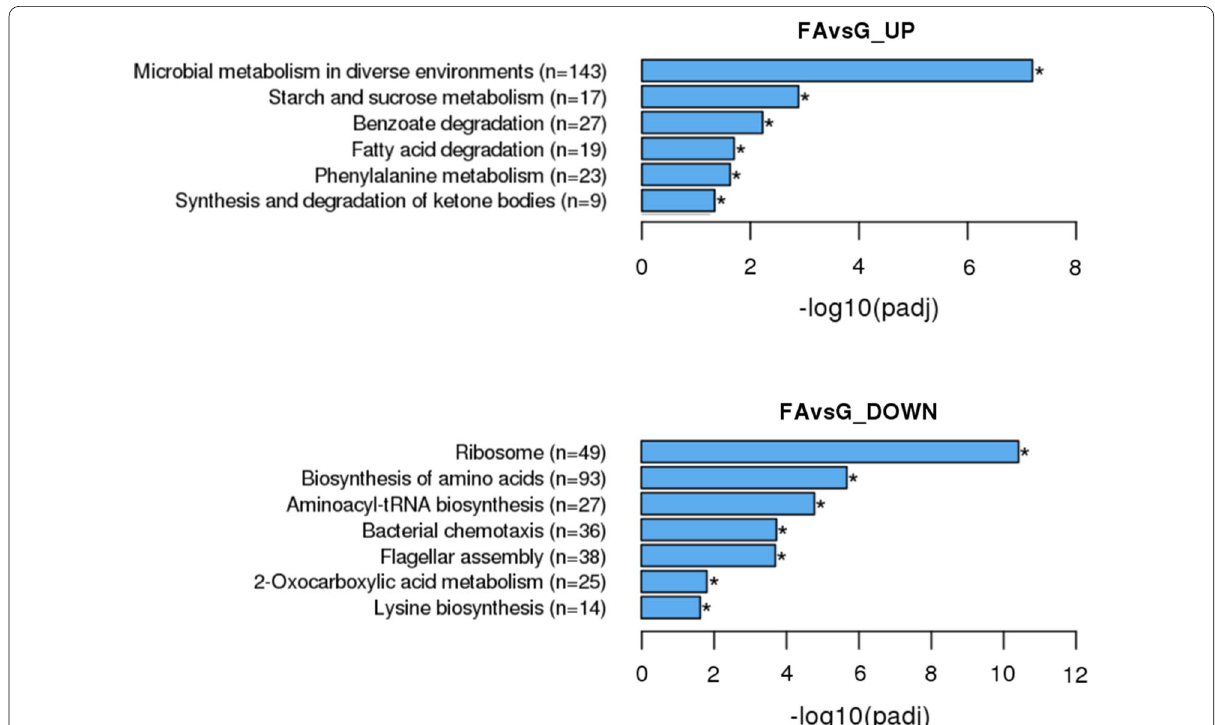
Fig. 3 Significantly up- and downregulated KEGG terms. The upper panel represents the upregulated terms and the lower panel the downregulated terms of P. aromaticivorans cultivated with ferulic acid in comparison to glucose as sole carbon source. Bars represent the -log10 adjusted p